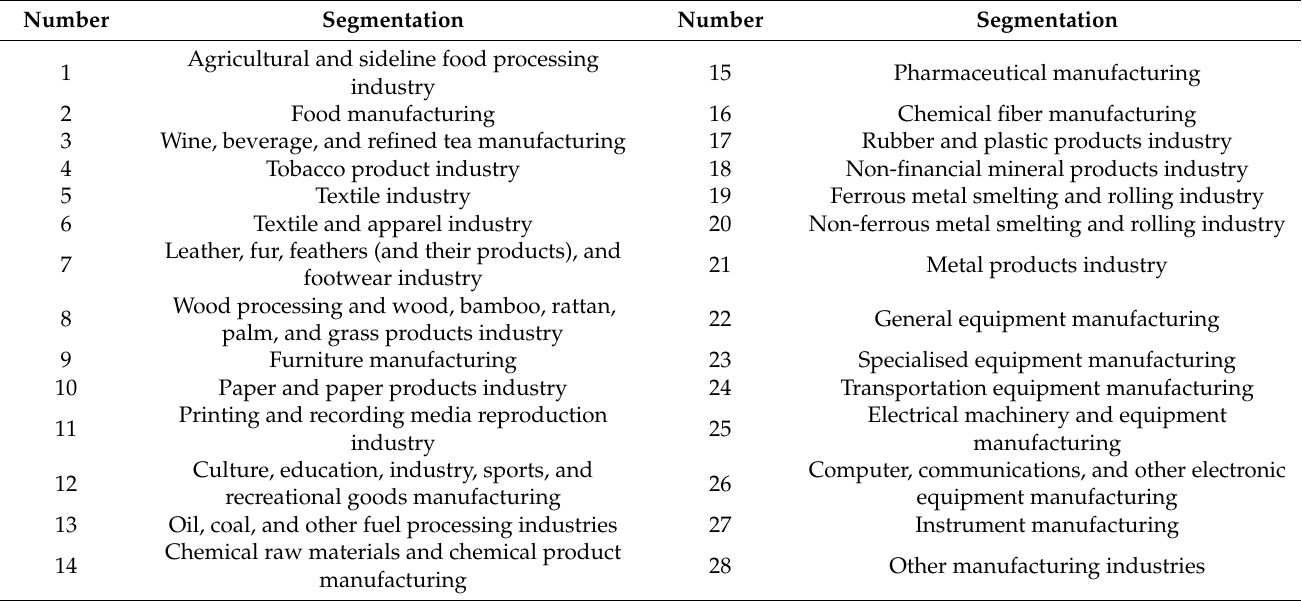
Table 2. Manufacturing industry segmentation